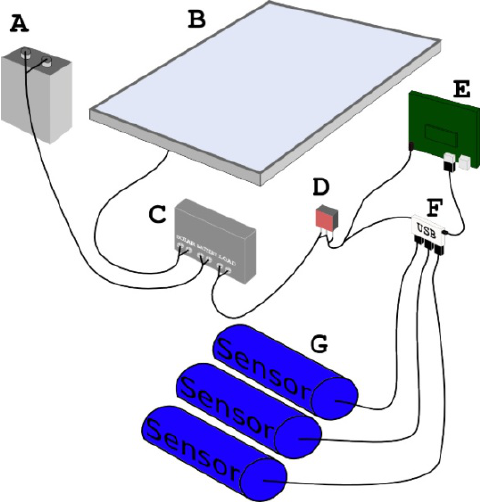
Figure 10. The power system for the SEMAT Mk2